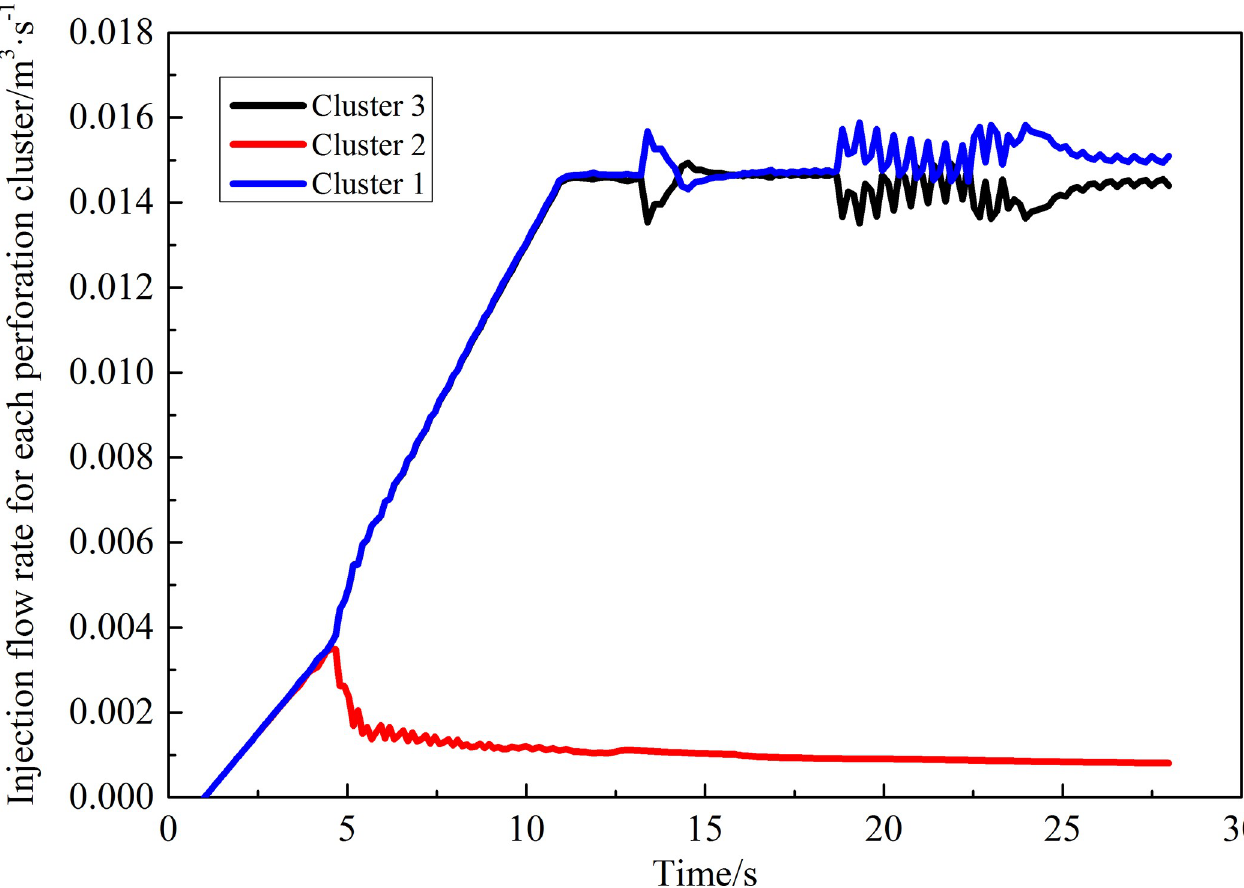
Fig 19. Quantity of flow distribution between clusters before